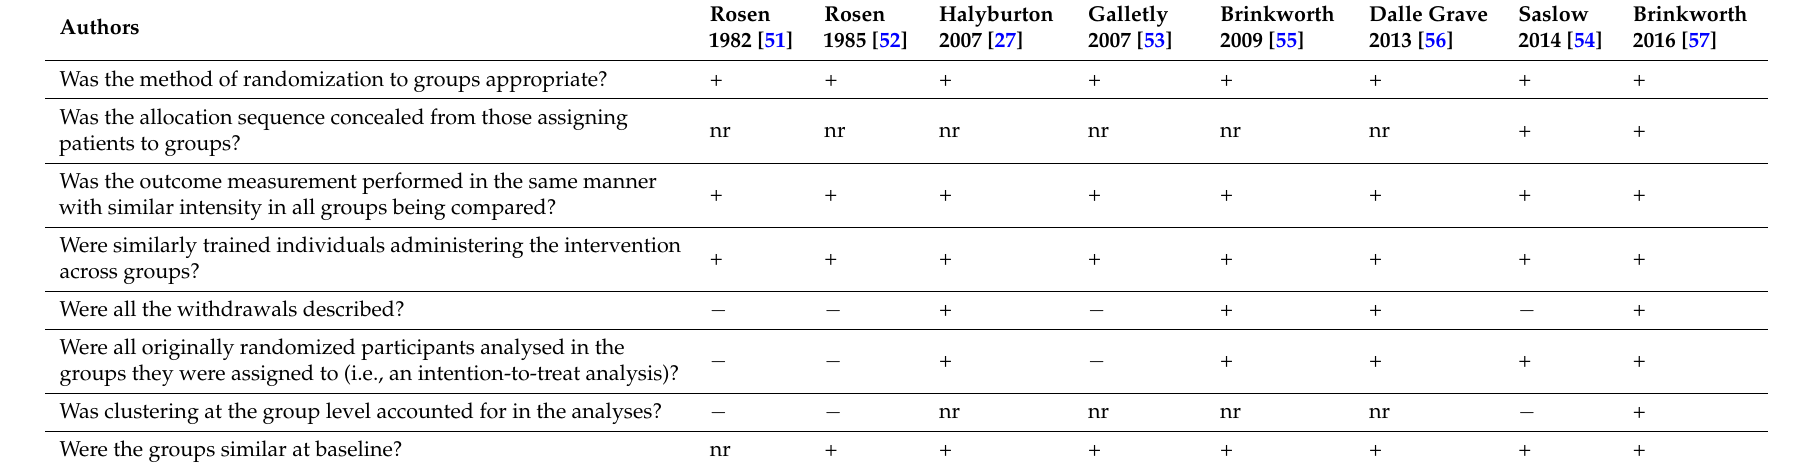
Table 2. Risk-of-bias